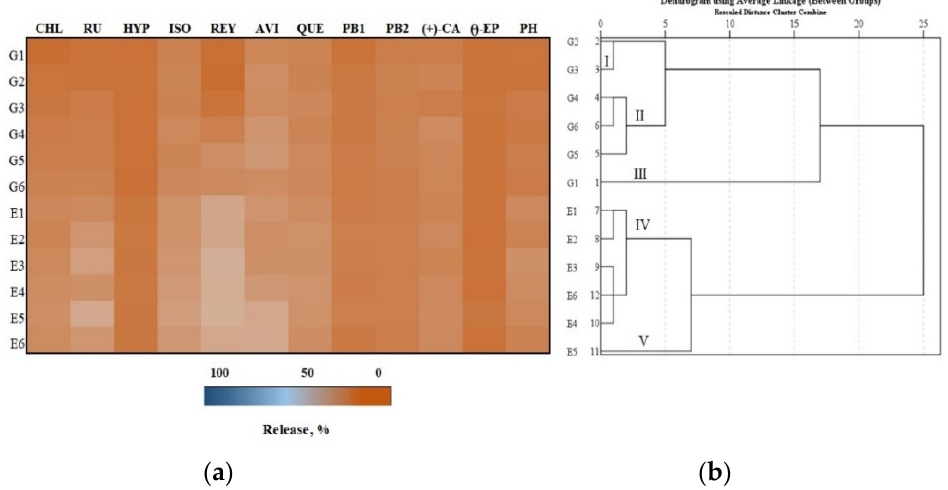
Figure 3. In vitro release test results: ( a ) Heatmap shows the percentage release of individual phenolic compounds from experimental gels (G1–G6) and emulgels (E1–E6) after 2 h; ( b ) the dendrogram illustrates variation in the total amount of phenolic compounds from experimental formulations after 2